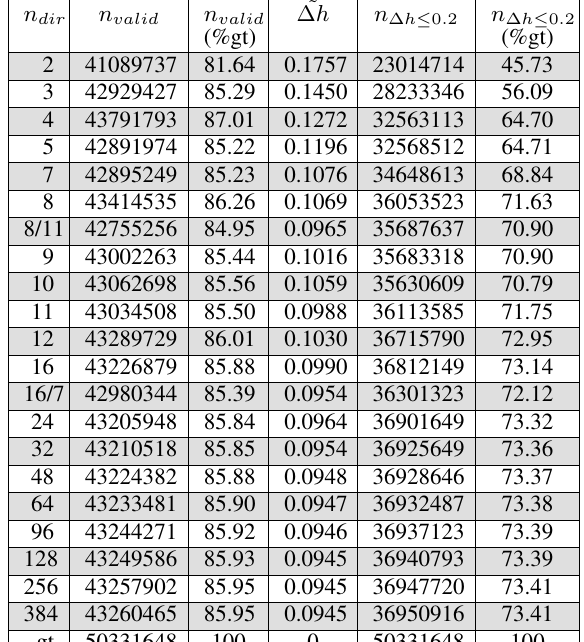
Figure 7. Dense reconstruction of wall surfaces with perspective distortion using SGM with eight orientations (a) RGB image, (b) height image with streaks of valid pixels Table 1. Coverage and accuracy for the synthetic stereo pair processed with different numbers of SGM path directions